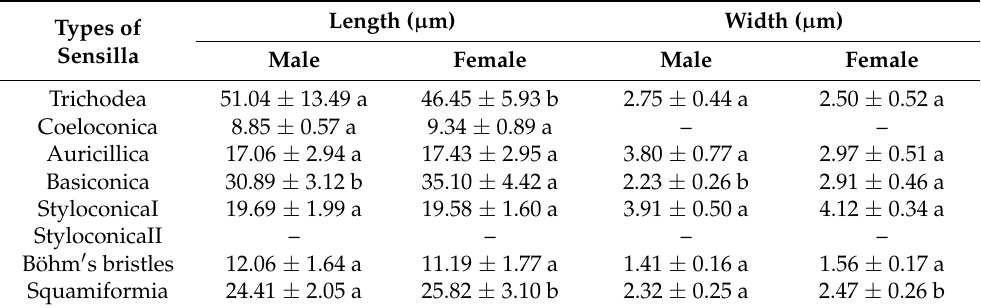
Table 2. Size of different antennal sensillum types in Dioryctria rubella adults obtained from SEM images.